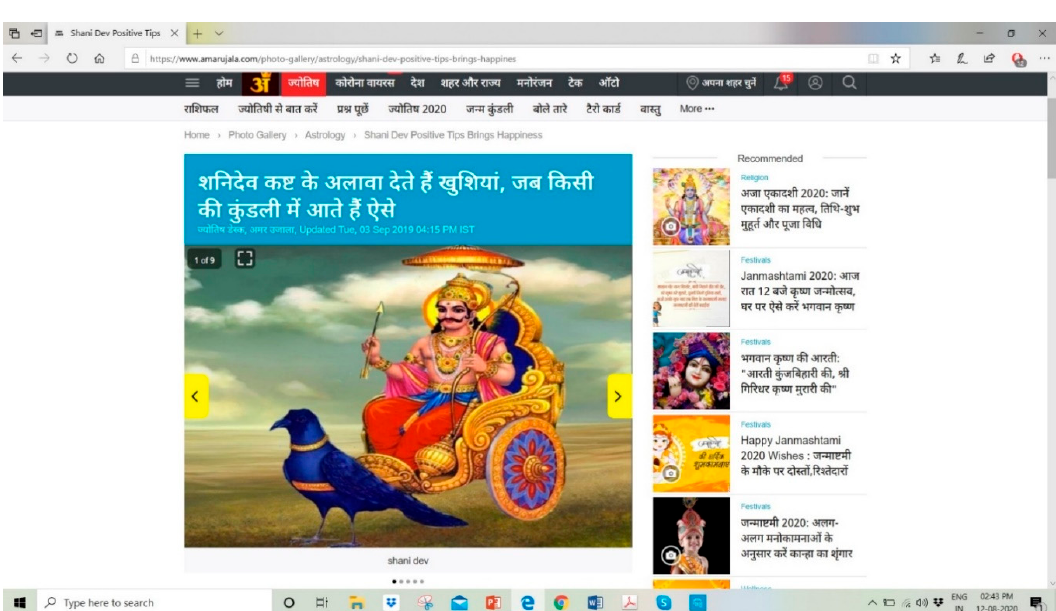
Figure 3. Shani riding the crow. Source: Jagaran. Religions 2020 , 11 , x FOR PEER REVIEW